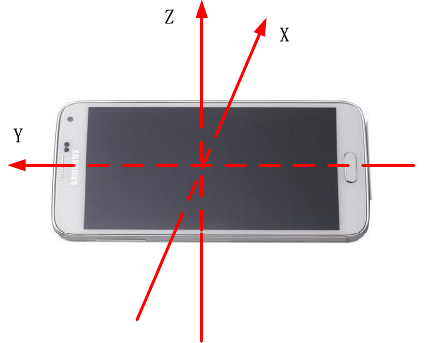
Figure 11. Body coordinate frame with respect to the receiver.